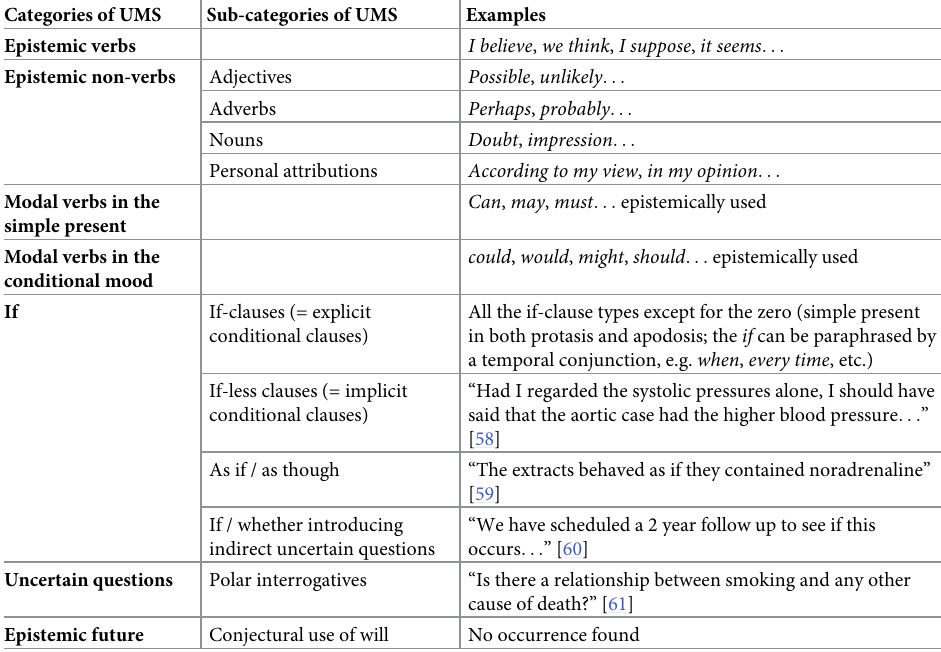
Table 1. UMs categories and